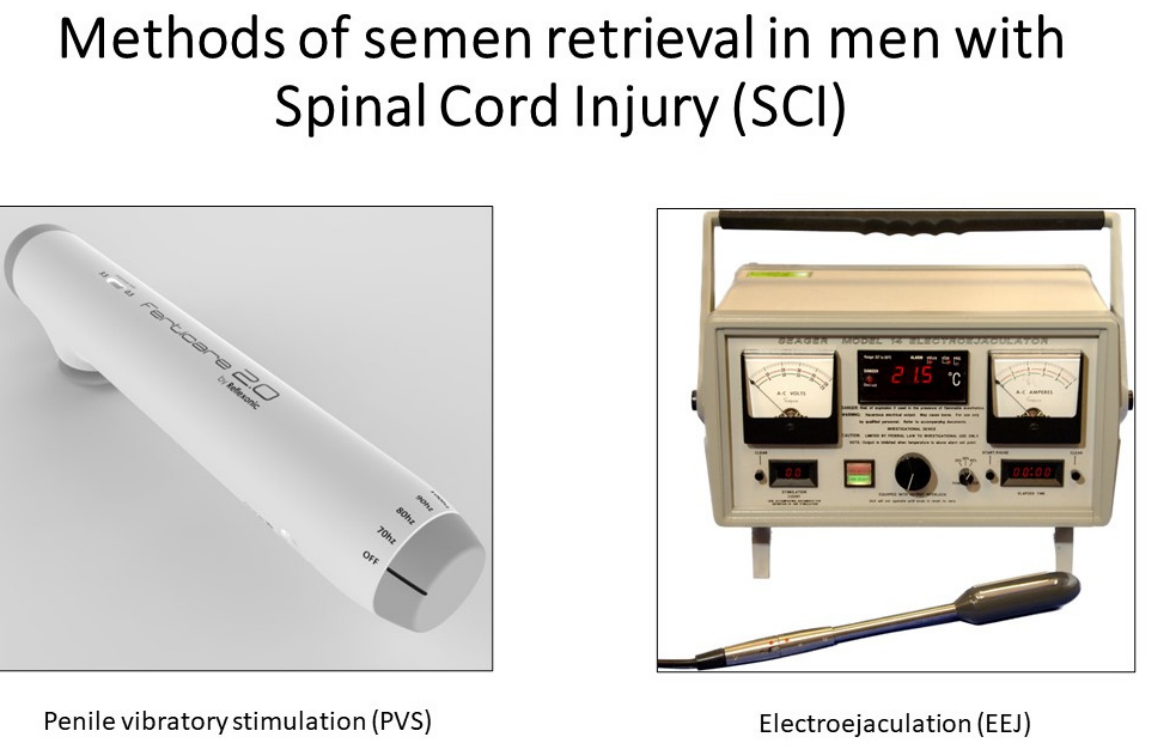
Figure 1. Ferticare 2.0 and Seager Electroejaculation machine are used for semen retrieval in men with with SCI.